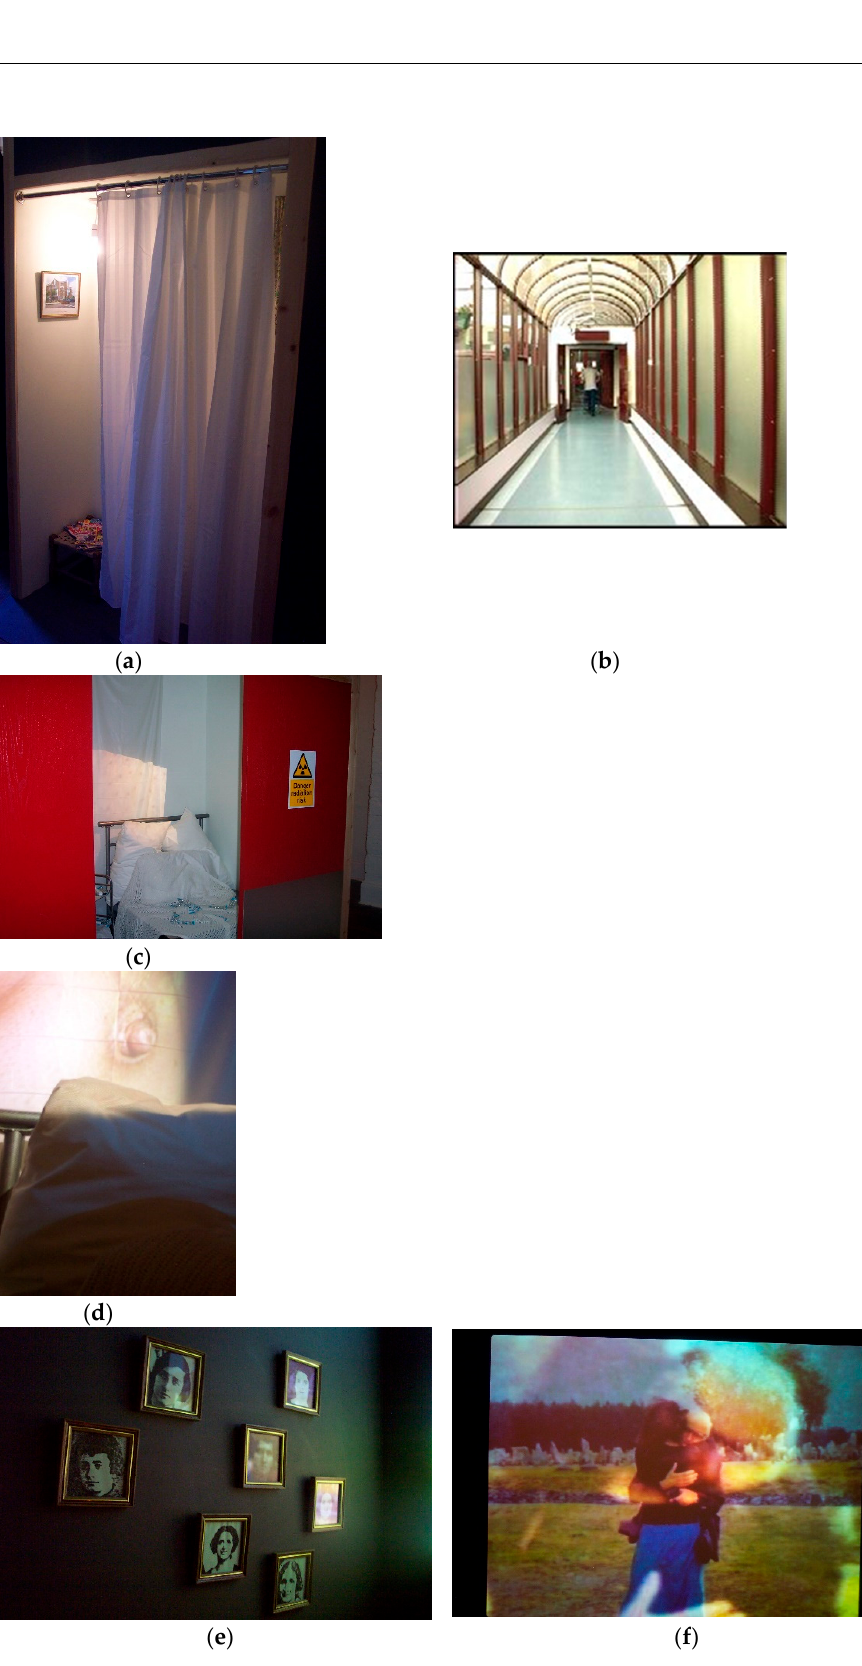
Figure 9. ( a ) Lorna Brunstein, How Come I Got It Then? 2006. Installation, Walcot Chapel, Bath. Detail of the “Waiting Room” in Booth 1, “The Journey” (left); ( b ) Detail of a video in Booth 1, “The Journey” (right). Courtesy of Lorna Brunstein; ( c ) Detail of Booth 2, “The Red Doors” (left); ( d ) Detail of a video in Booth 2, “The Red Doors” (right); ( e ) Detail of Booth 3, “Farewell” (left); ( f ) Detail of a video in Booth 3, “Farewell”